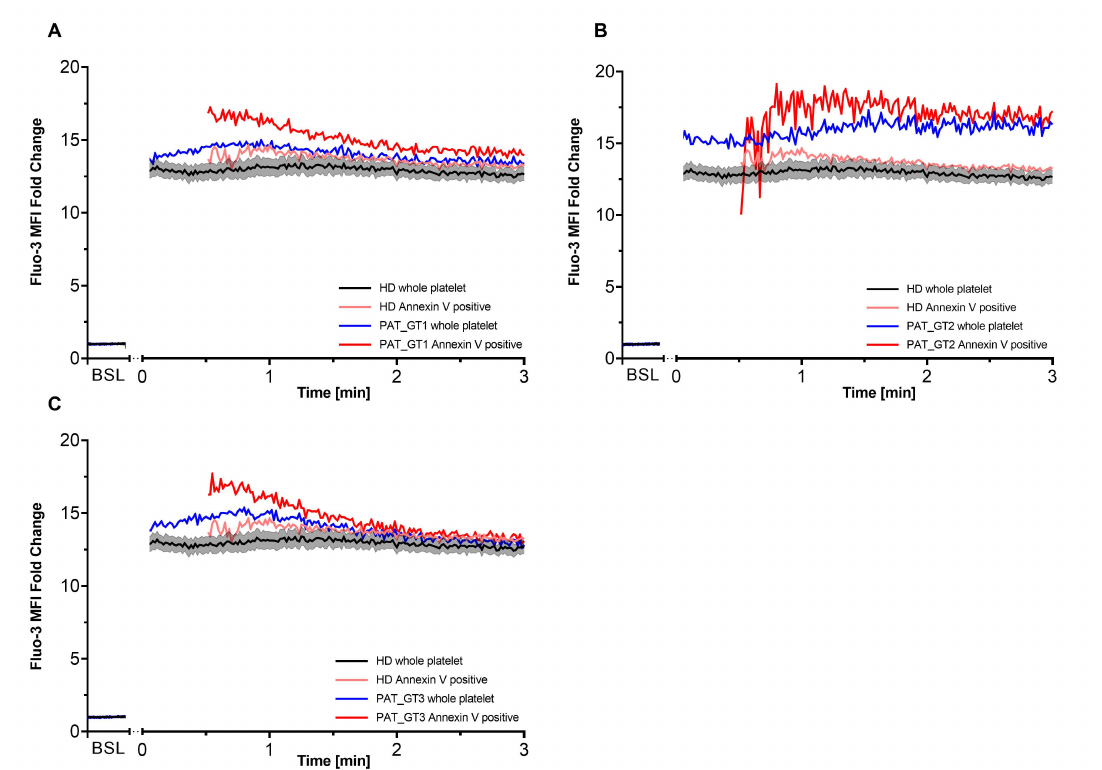
Figure 3. Intracellular calcium within first 3 min after activation. Each of the three patients with Glanzmann thrombasthenia (GT) had their first 3 min kinetics after activation plotted with respect to their Fluo-3 median fluorescence intensity (MFI) fold change compared to healthy donors (HD). Co-staining with Cy5 Annexin V allowed di ff erentiating procoagulant COAT platelets (Annexin V positive) from the whole platelet population. ( A ) PAT_GT1; ( B ) PAT_GT2; ( C ) PAT_GT3. HD data are mean ± SEM from experiments with platelets from di ff erent donors ( n = 6). Data for each GT patient are a mean of individual replicates, n = 3 for PAT_GT1, n = 1 for PAT_GT2, and n = 2 PAT_GT3. Baseline,